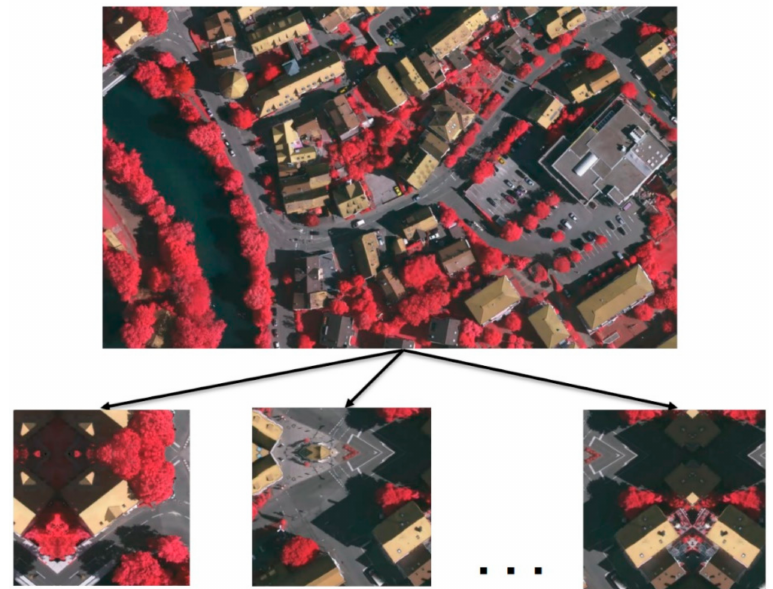
Figure 3. Data crop and